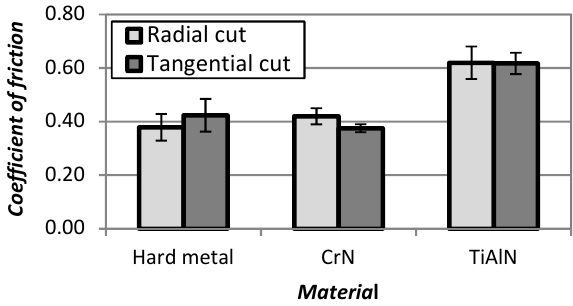
Figure 8. Static coefficient of friction between different cuts of oak wood (radial and tangential) and hard metal WC-Co with and without PVD coatings.